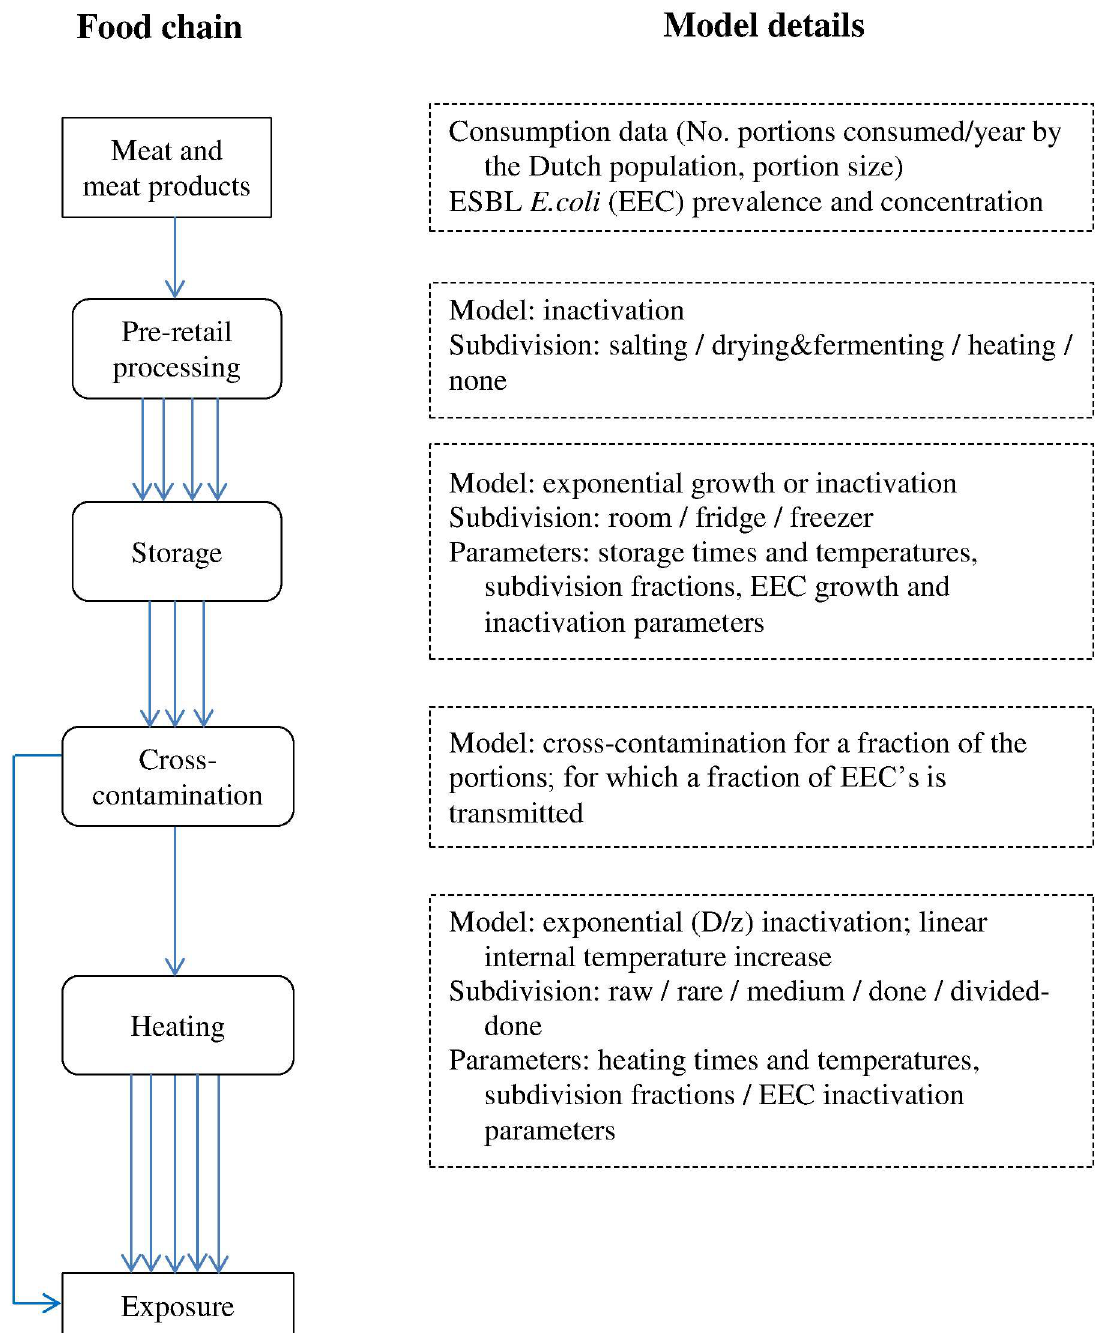
Fig 1. Overview of the sQMRA model used for the calculations. In- and output (text box with straight corners), processes (roundedcorners) and details(dashedlines) are